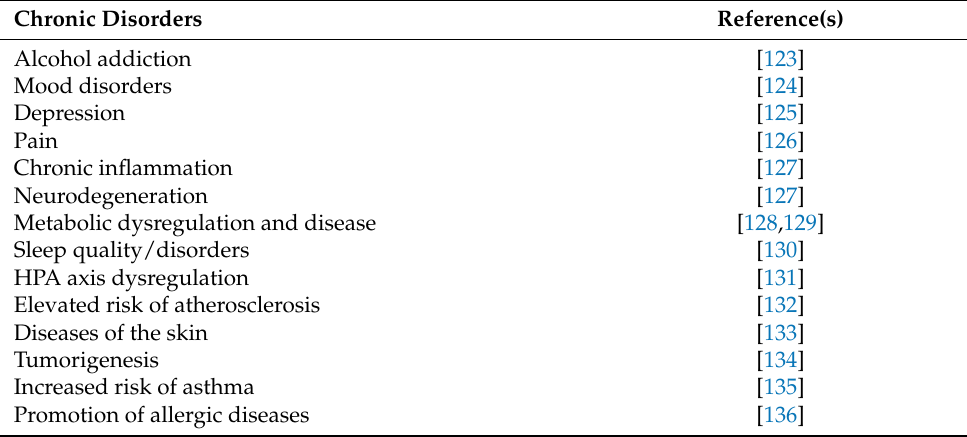
Table 5. Examples of Circadian Disruption and Adverse